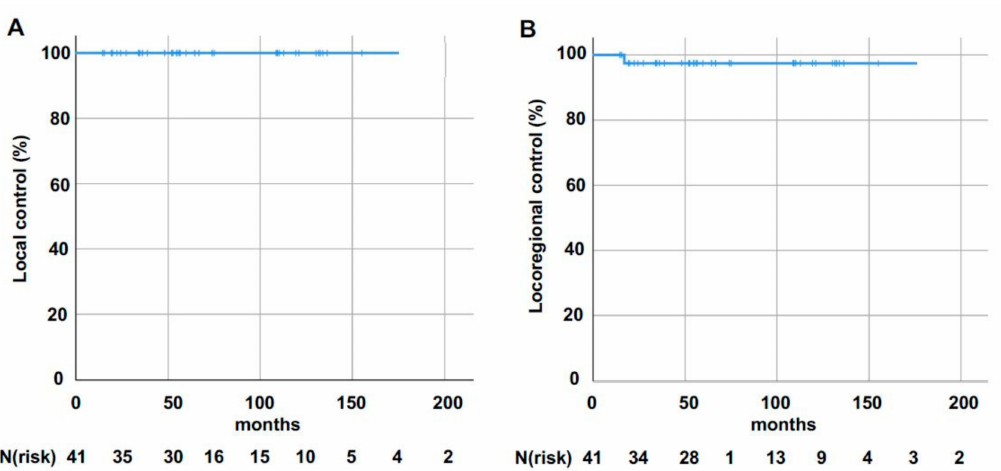
Figure 1. Kaplan–Meier-estimated local ( A ) and locoregional ( B ) control following surgical resection and postoperative radiotherapy for male breast cancer (MBC).